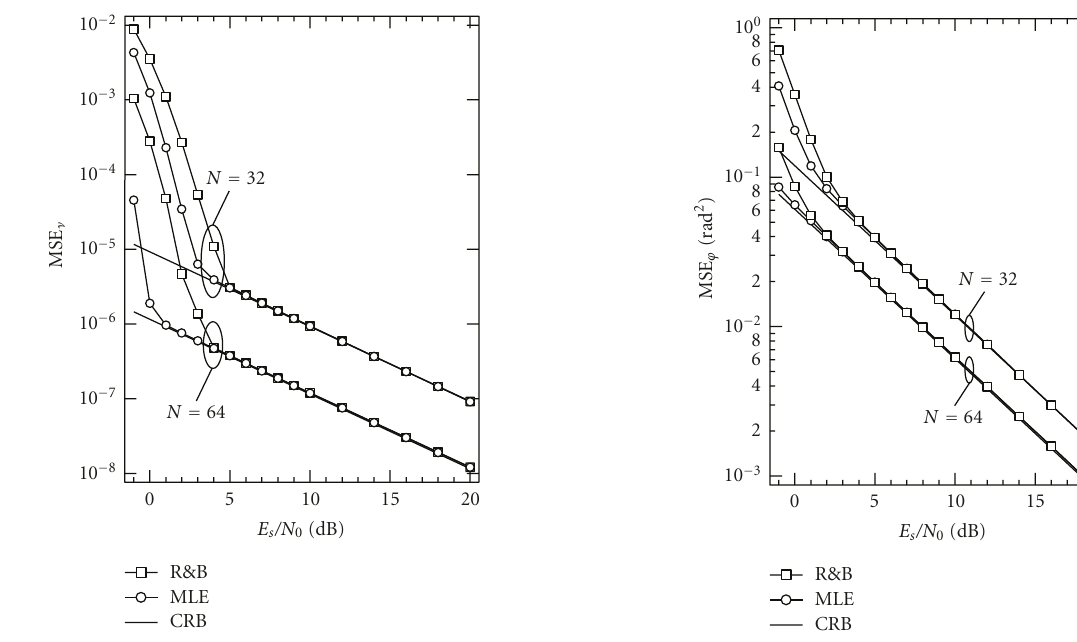
Figure 9: Mean square error MSE ϕ versus E s /N 0 with N = 32 and N =